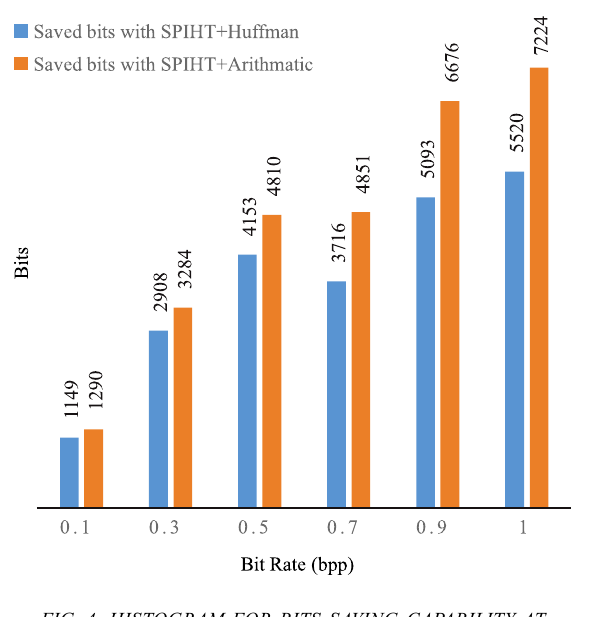
FIG. 4. HISTOGRAM FOR BITS SAVING CAPABILITY AT GIVEN RATES FOR LENA 512